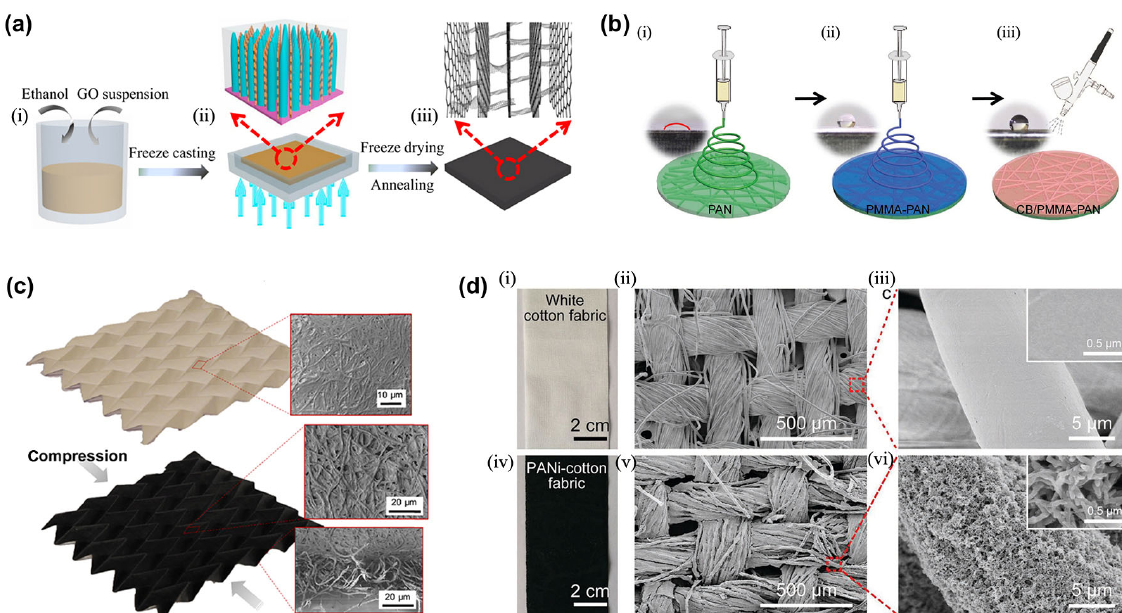
Figure 6 The 2-D substrates with small thickness. (a) The polytetrafluoroethylene and cellulose membrane. Reproduced with permission from Ref. [90], © American Chemical Society 2017. (b) A Janus structure membrane based on electrospinning technology. Reproduced with permission from Ref. [92], © WILEY-VCH Verlag GmbH & Co. KGaA, Weinheim 2018. (c) An origami structure is folded with filter paper. Reproduced with permission from Ref. [64], © American Chemical Society 2018. (d) A cotton fabric substrate. Reproduced with permission from Ref. [101], © WILEY-VCH Verlag GmbH & Co. KGaA, Weinheim